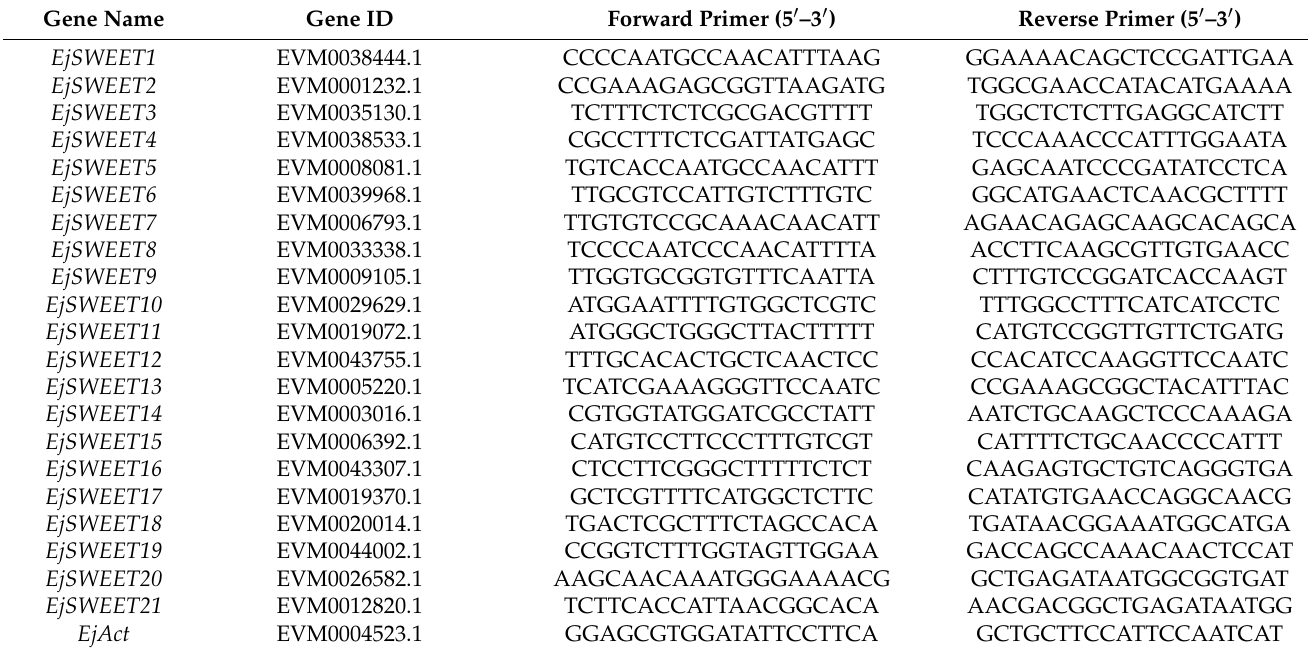
Table 1. Primer sequences of EjSWEET